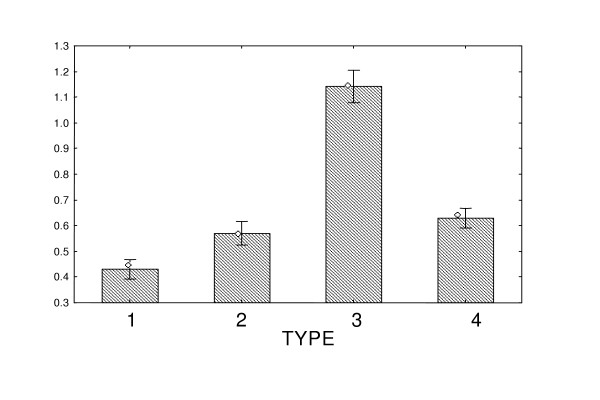
Coefficient of variation in spatial cluster size for four types of DNA: exons (1), non-fluffy NCNR (2), fluffy NCNR (3), regulatory regions (4); Vertical bars denote 95% confidence intervals. The Y axis shows coefficient of variation, the X axis is for four DNA type. We calculated CV based on spatial clustering coefficient k = 1.